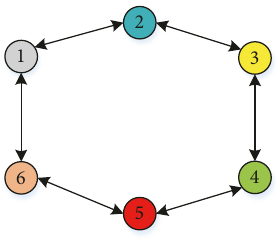
Figure 1: System